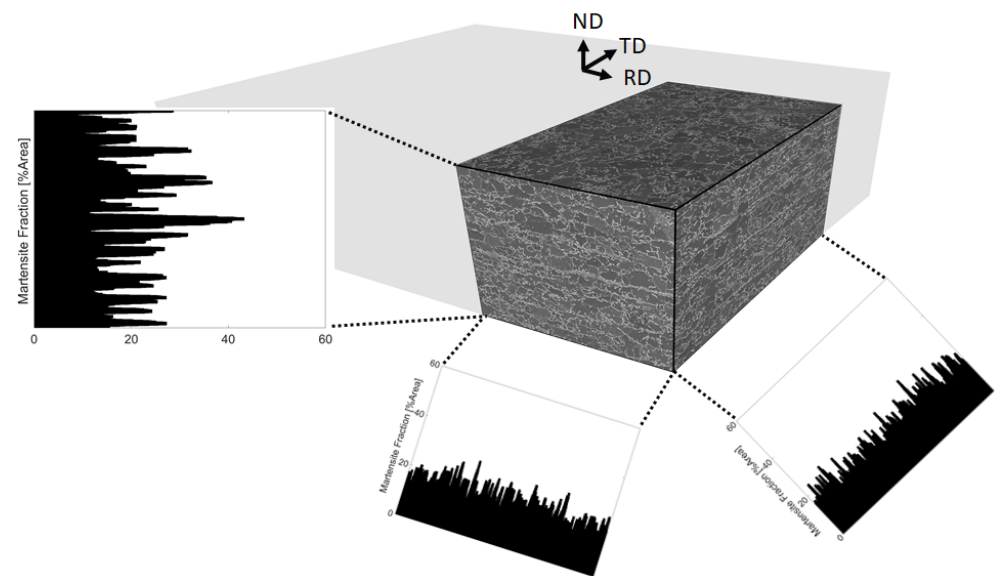
Figure 1. Typical microstructure of a commercial DP600 steel and distribution of vol% martensite where ND (normal direction) represents the direction normal to the plane of sheet and RD and TD represent the rolling and transverse directions of the